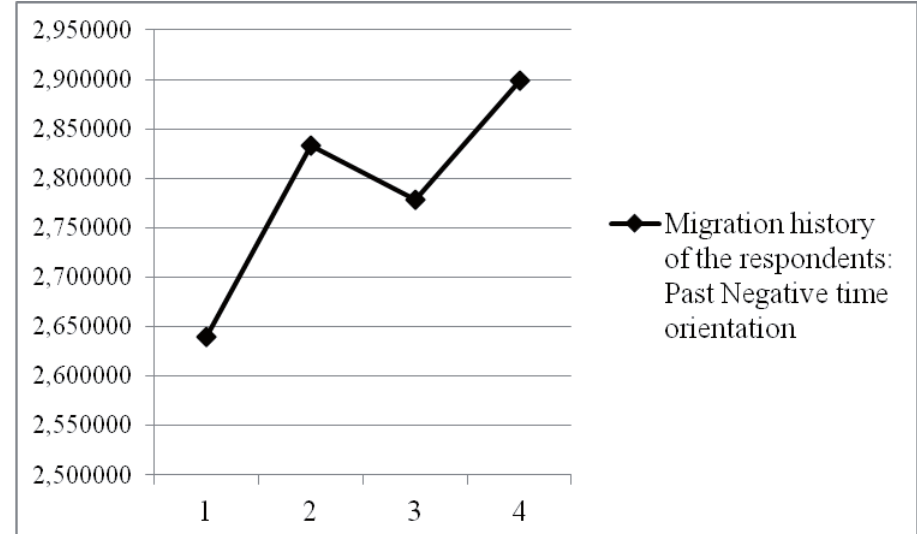
Fig. 4. Average values according to the scale „Past Negative” in subgroups di- vided on the basis of migration history of the respondents: 1 – residents of oblast centres including those who spent there their childhood as well as those who came to an oblast centre from a small town (n = 278), 2 – residents of small towns who had grown up there (n = 55), 3 – those respondents who spent their childhood and currently live in villages (n = 70), 4 – residents of oblast centres who spent their childhood in a village or town-like settlement (n =